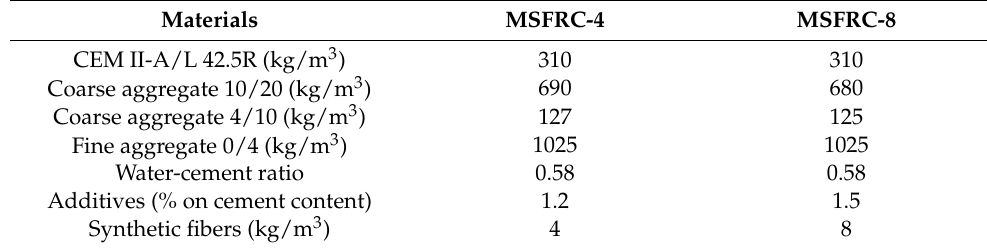
Table 1. Composition of studied MSFRC.